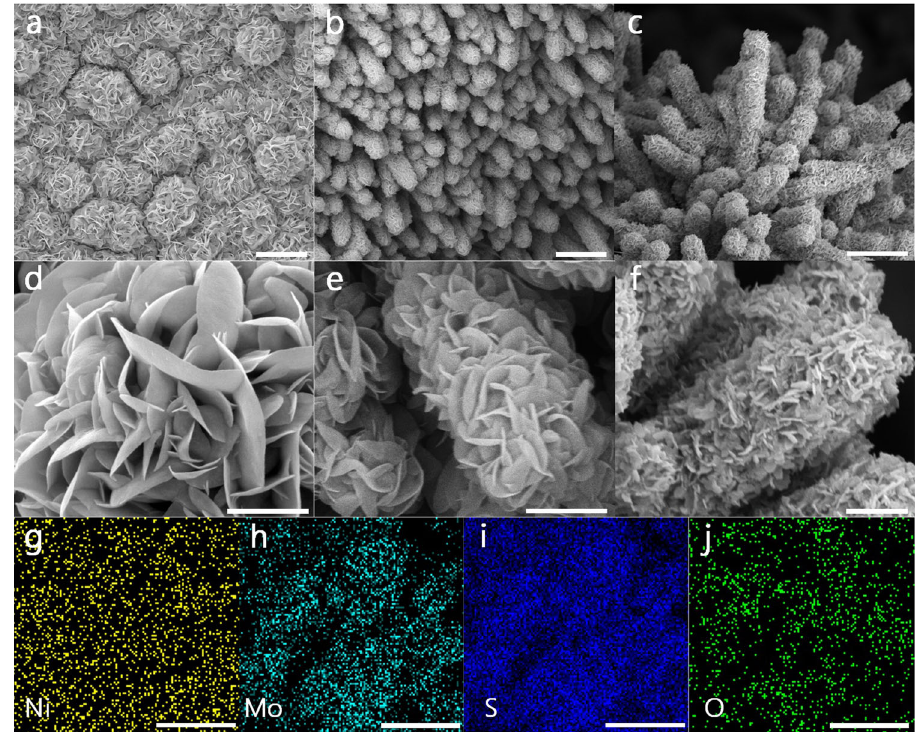
Fig. 2 Morphological and structural characterizations. SEM images of a , d MoS 2 , b , e NiMoS, c , f NiMoO x /NiMoS. g – j Elemental mapping images of NiMoO x /NiMoS. Scale bar, a – c 5 μ m; d – f 1 μ m; g – j 10 μ